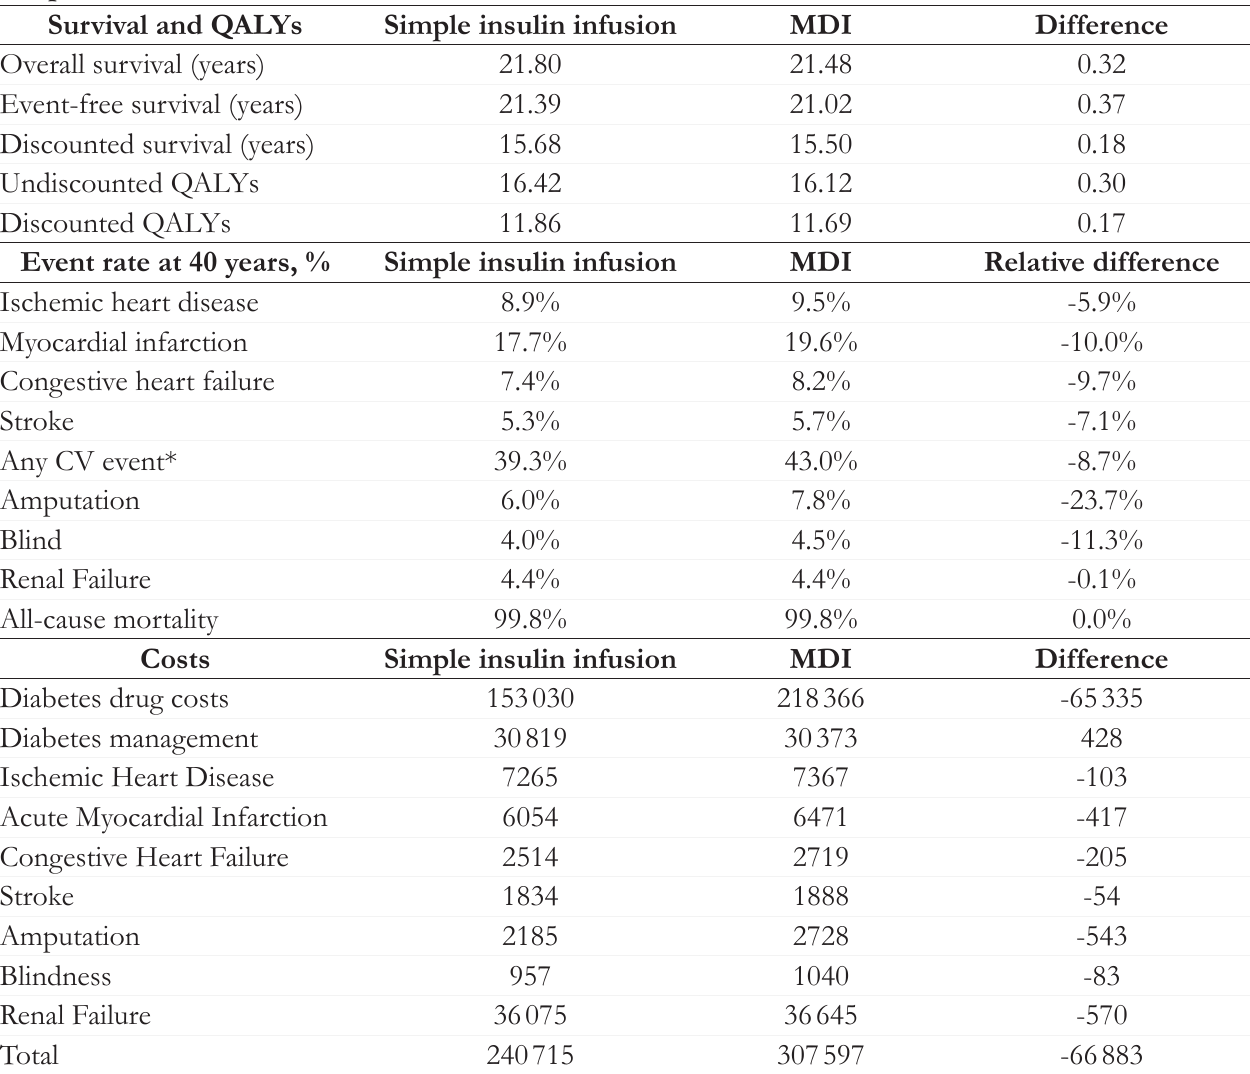
Table 4. Estimated Survival, Quality Adjusted Life Years, Estimated Event Rates at 40 Years and Estimated Costs (USD) of T2D Drugs, Management and Complications for People with T2D